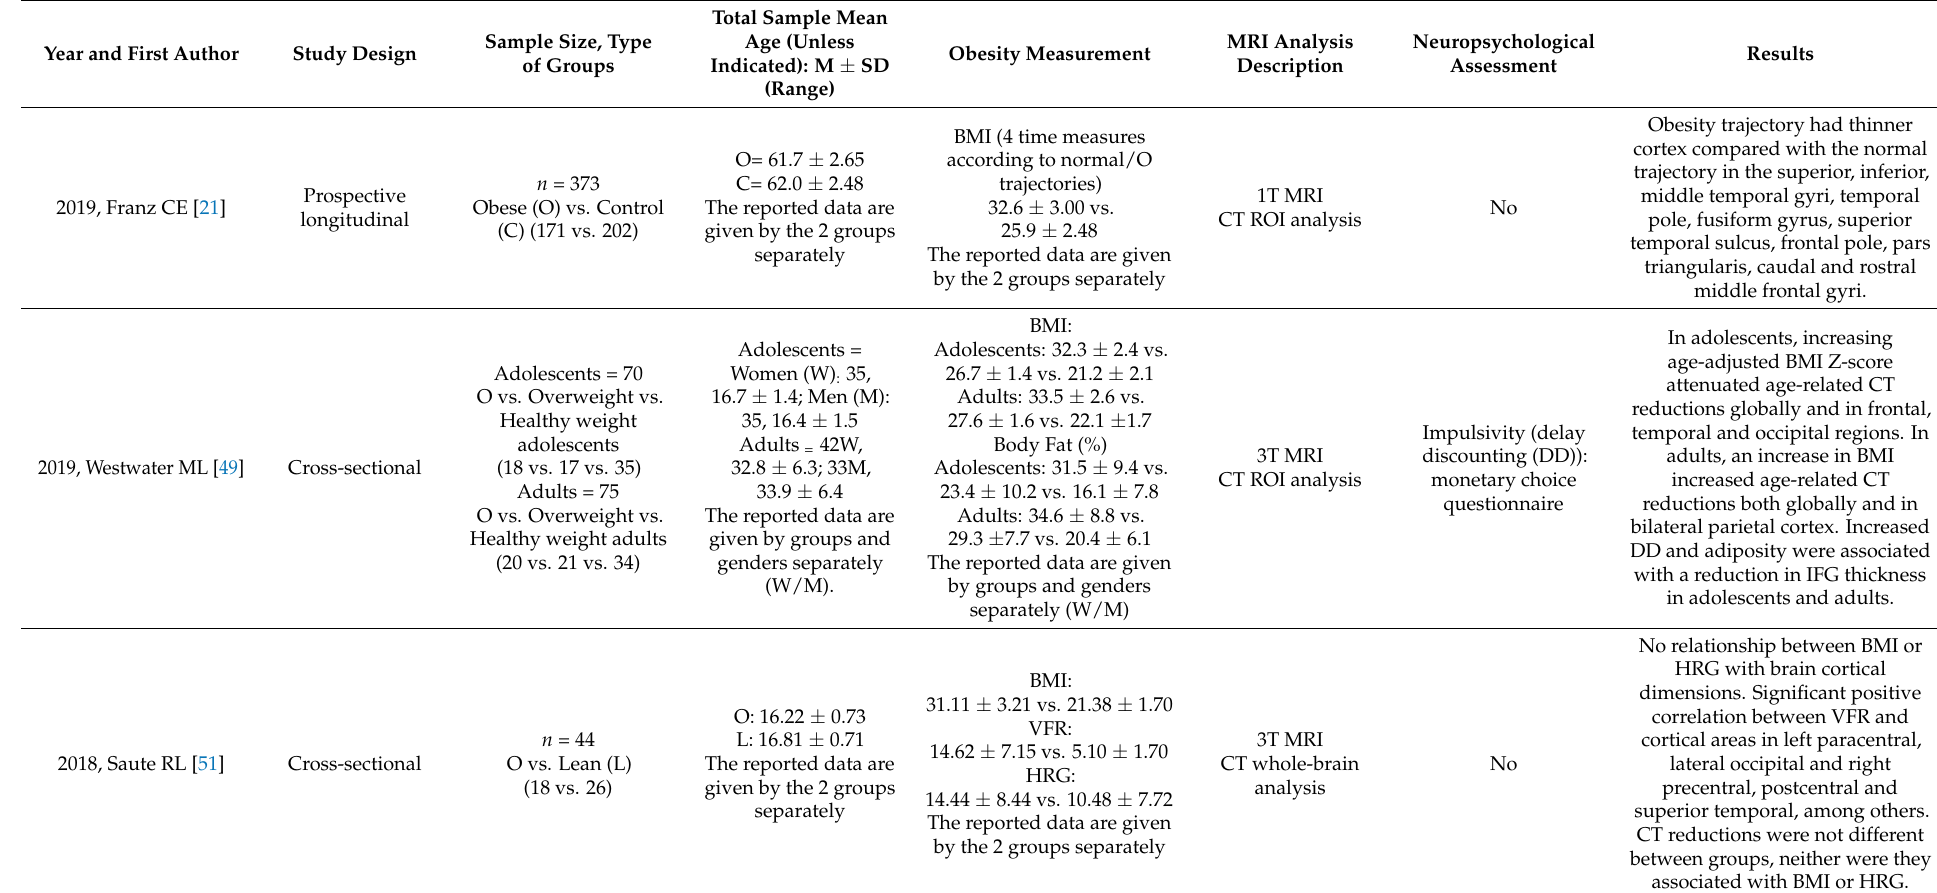
Table 1. Summarized data of the studies included in the review. Articles are shown in chronological